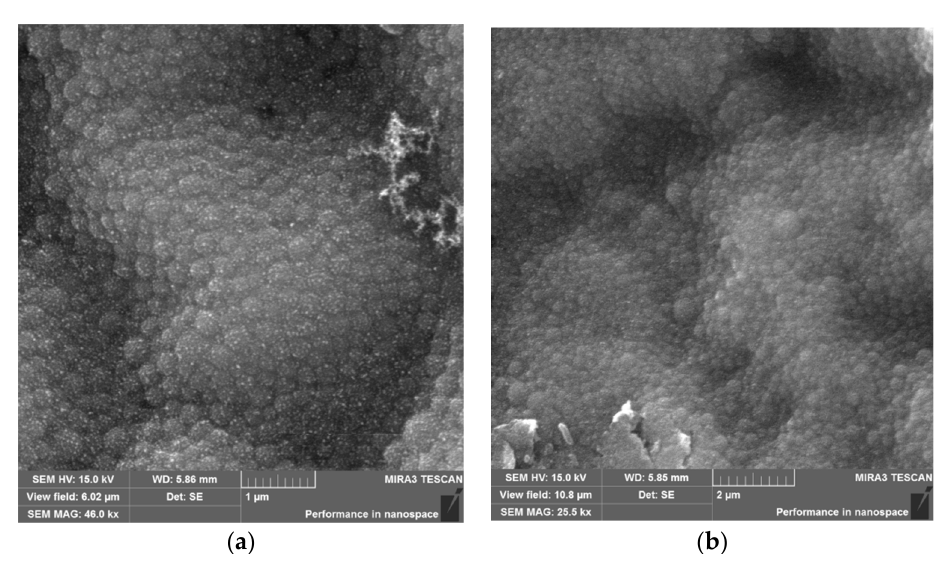
Figure 3. Microscope images: ( a ) Scanning electron microscope (SEM) image of HSA-NPs of a size of 196 ± 5 nm and a charge of 15 kV prepared under optimized experimental conditions (scale = 1 µm); and a ( b ) SEM image of HSA–HU-NPs, size of 288 ± 10 nm and a charge of 15 kV prepared from optimized experimental conditions with 2 mg/mL starting HU concentration (scale = 2 µm).